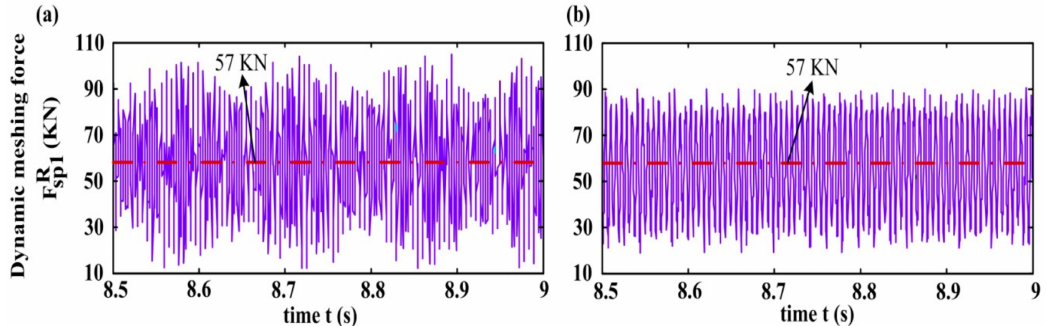
Figure 8. Variation of the dynamic meshing force on the right-side external meshing pair with gear mesh time, expressed as F R . ( a ) the model with the planet–gear eccentric error excitation E p1 = 100 µ m, sp1 ( b ) the model without error excitations.